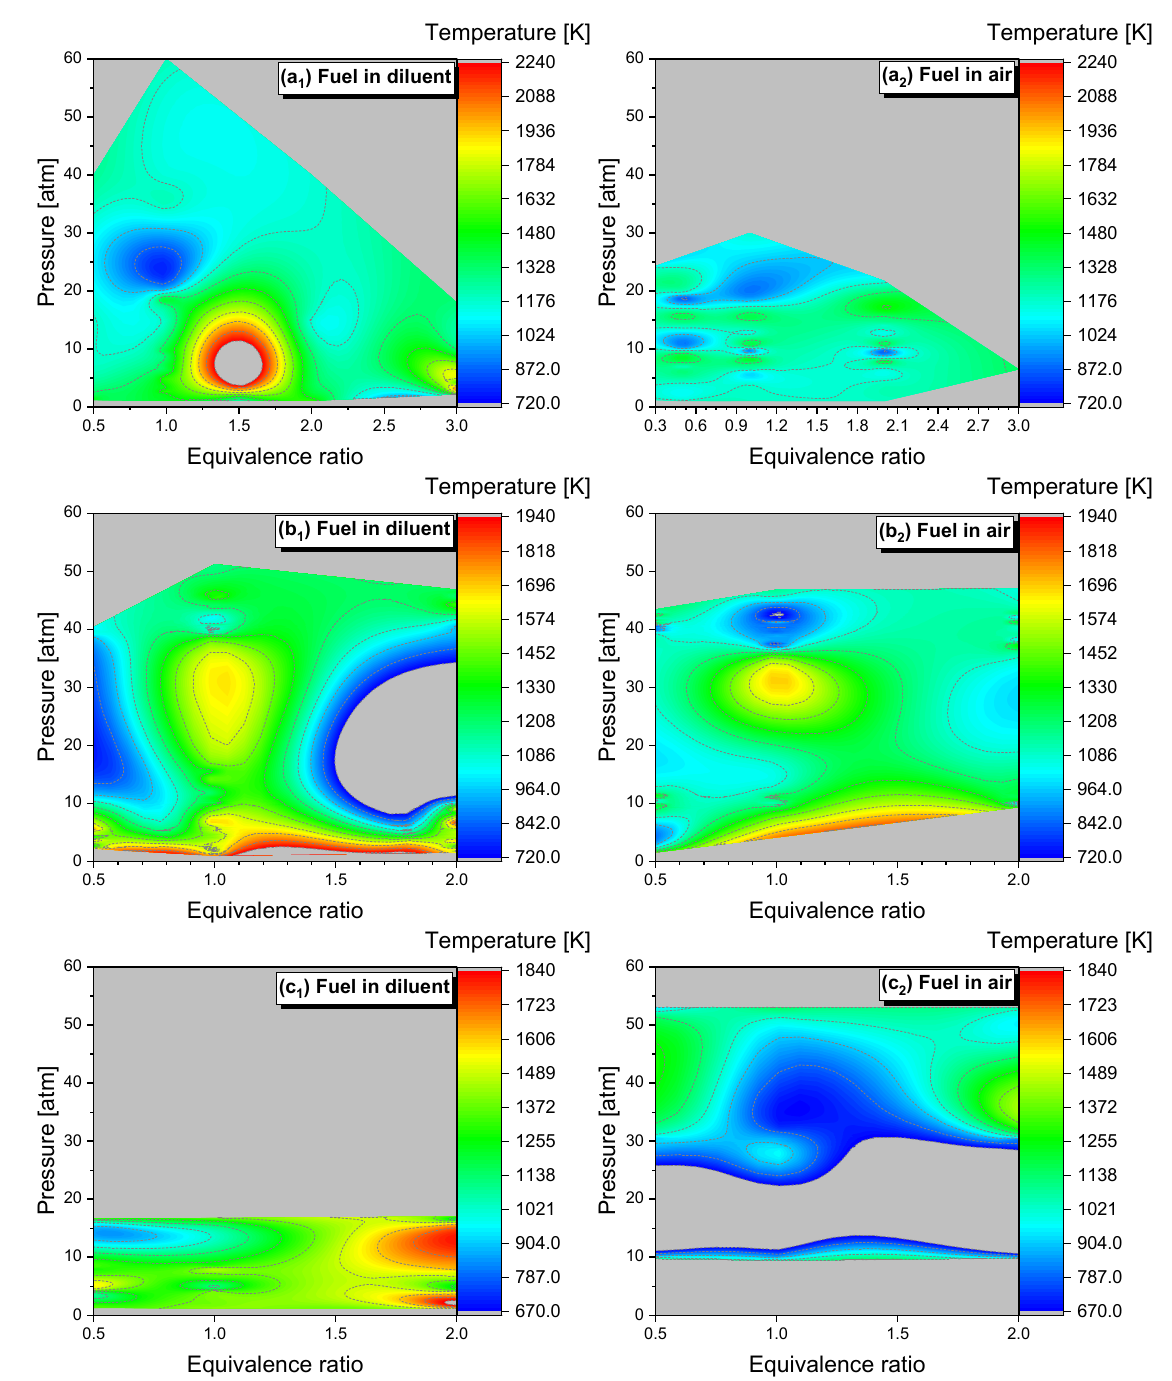
Figure 4. Three-dimensional plots representing the approximate range of temperatures, pressure and equivalence ratios at which alkene IDTs have been studied. ( a 1 )/( a 2 ) ethylene, ( b 1 )/( b 2 ) propene, ( c 1 )/( c 2 ) 1-butene.